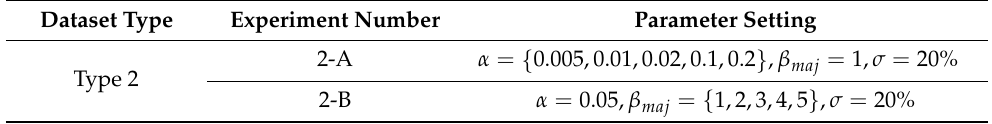
Figure 4. The effect of μ on the classification performance of Type 1. ( a ) Moore Dataset; ( b ) CICIDS 2017 Dataset Table 6. Experimental parameter settings of type